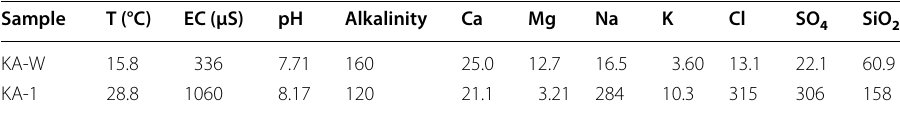
Table 2 Results of chemical analyses of KA-W and KA-1 water samples (all units in mg/L unless otherwise